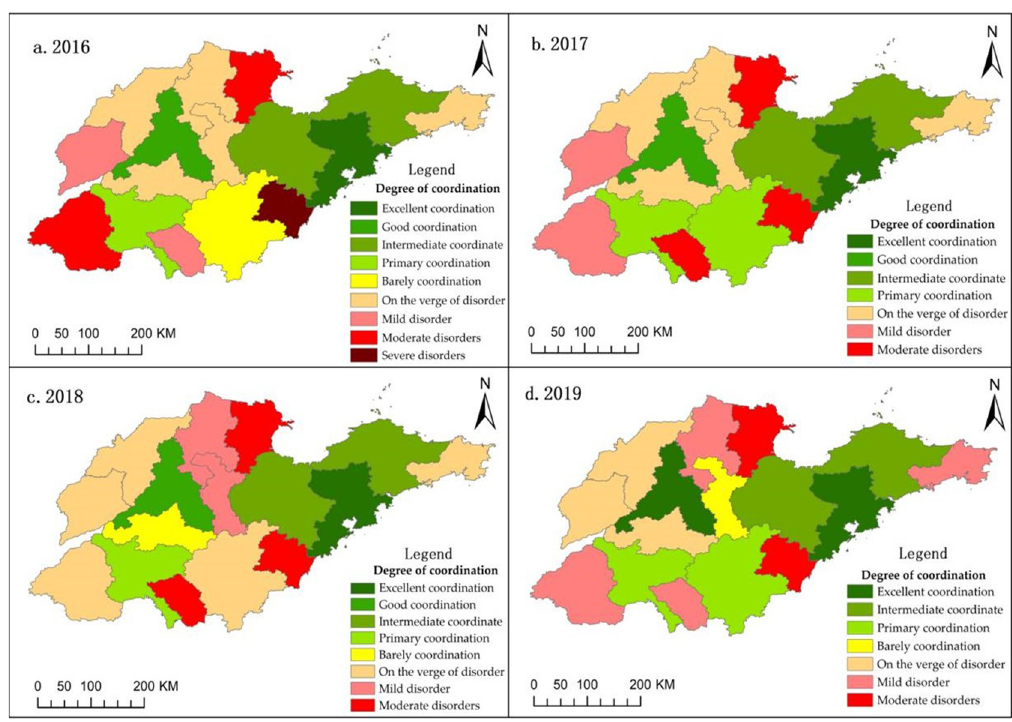
Fig 3. Spatial distribution pattern of coordination degree between urban agricultural informatization and agricultural economic development in Shandong Province, 2016 to 2019.